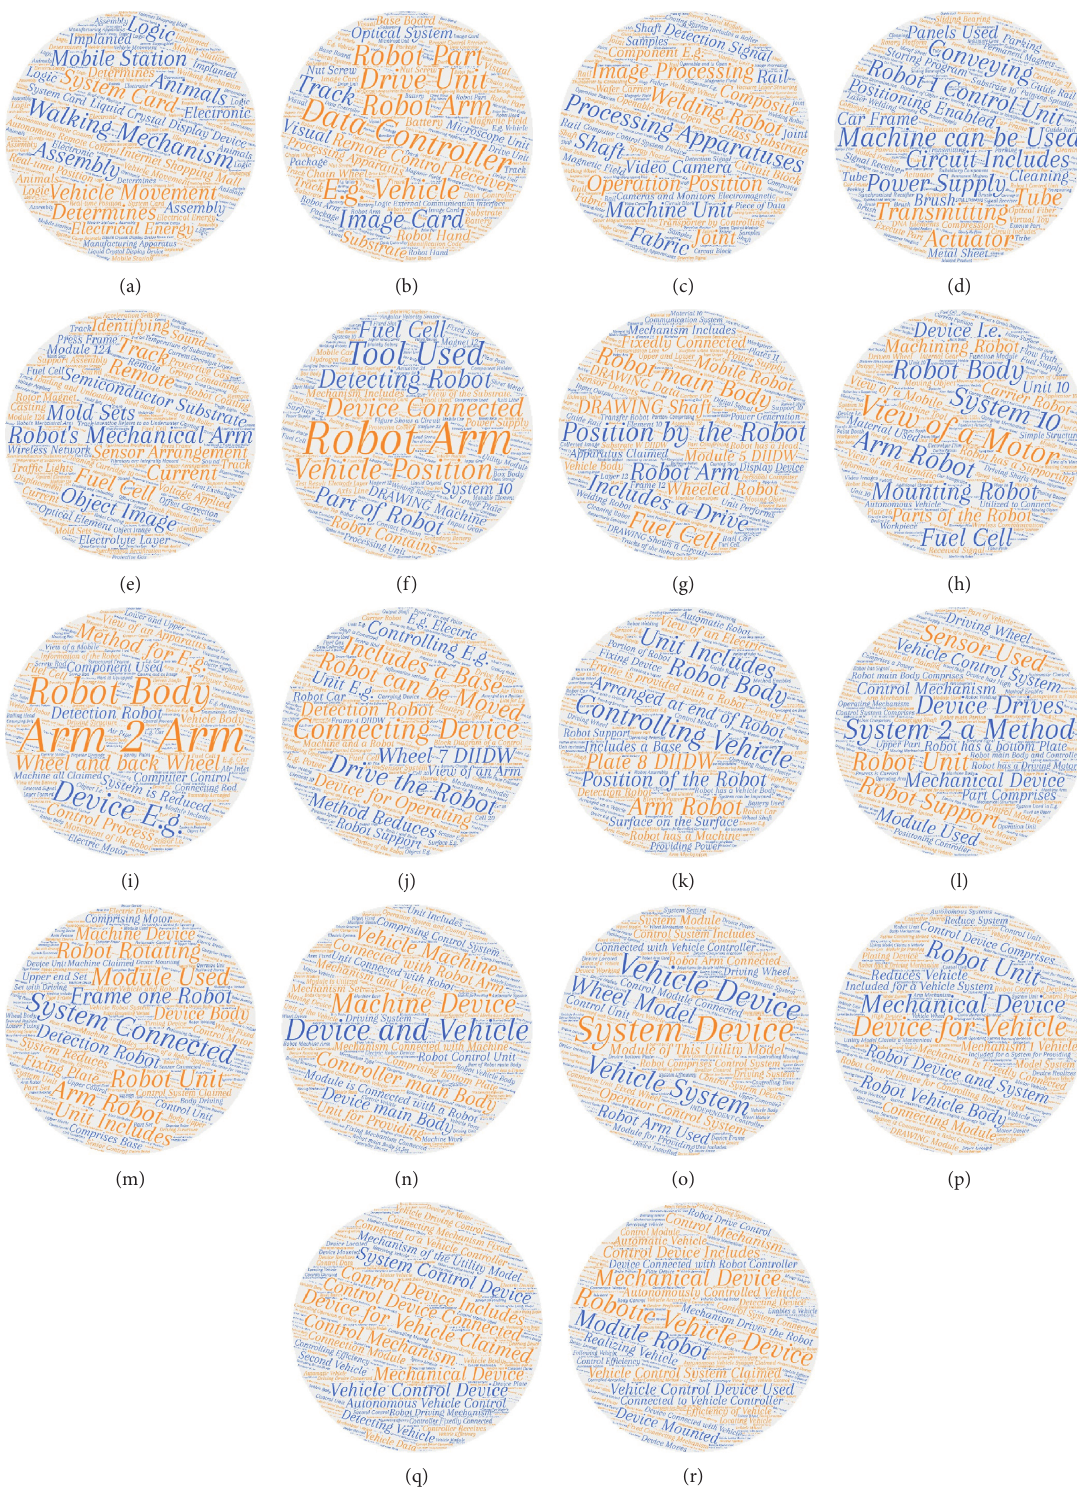
Figure 6: Clustering results of patents: (a) 2002; (b) 2003; (c) 2004; (d) 2005; (e) 2006; (f) 2007; (g) 2008; (h) 2009; (i) 2010; (j) 2011; (k) 2012; (l) 2013; (m) 2014; (n) 2015; (o) 2016; (p) 2017; (q) 2018; (r)